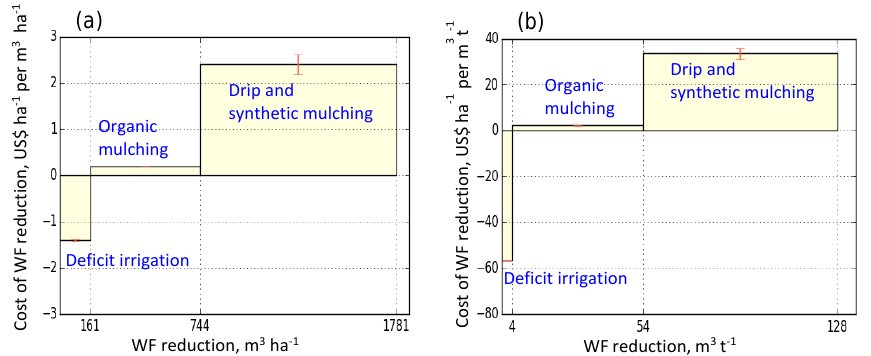
Figure 7. Marginal cost curves for WF reduction for maize for the baseline of furrow irrigation combined with full irrigation and no mulching. (a) WF reduction per area. (b) WF reduction per unit of product.